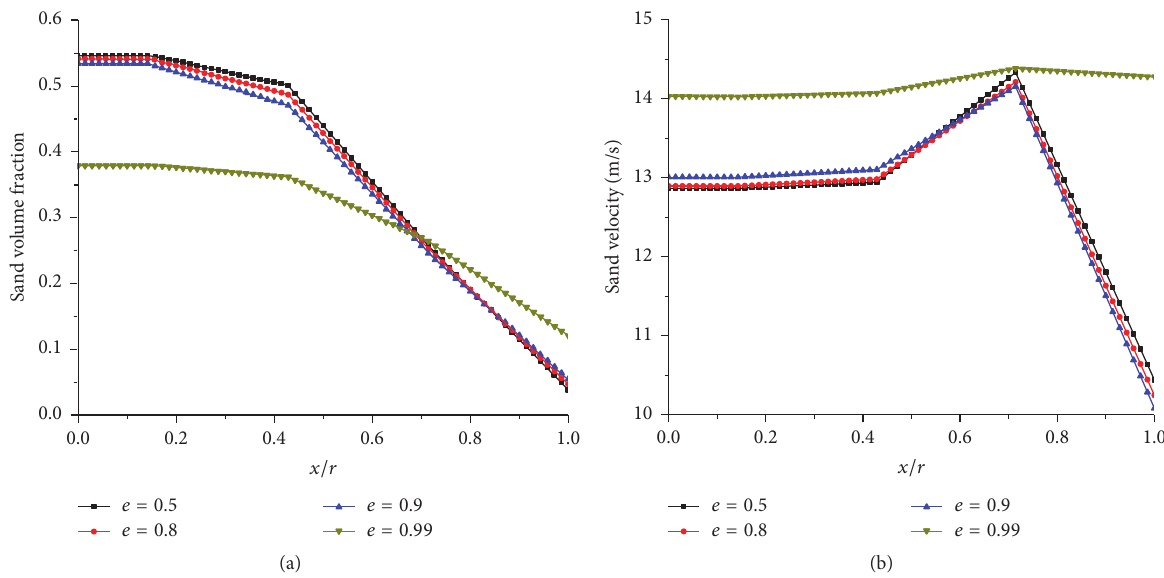
Figure 4: The distribution of (a) sand volume fraction and (b) sand velocity at the nozzle for different value of restitution coefficient 𝑒 ( 𝑡 = 160 ms, 𝑥 is the distance to the axis, and 𝑟 is the radius of the